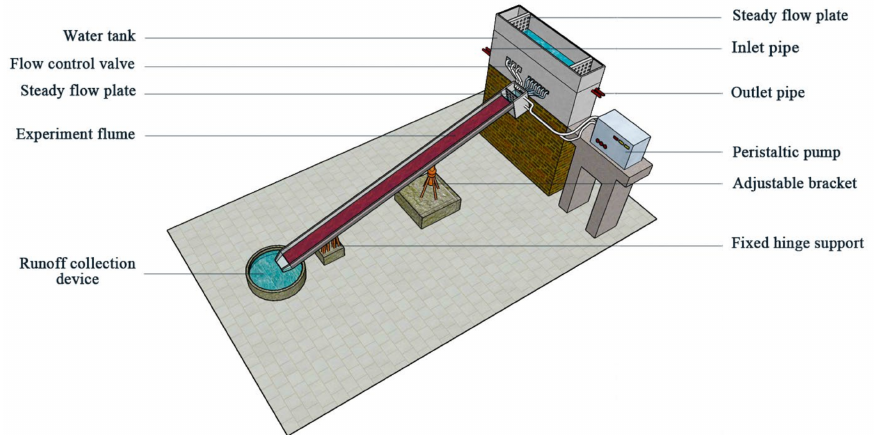
Figure 1. Test device (the device was developed and setup by the authors in Key Laboratory of Agricultural Soil and Water Engineering of the Ministry of Education in Arid